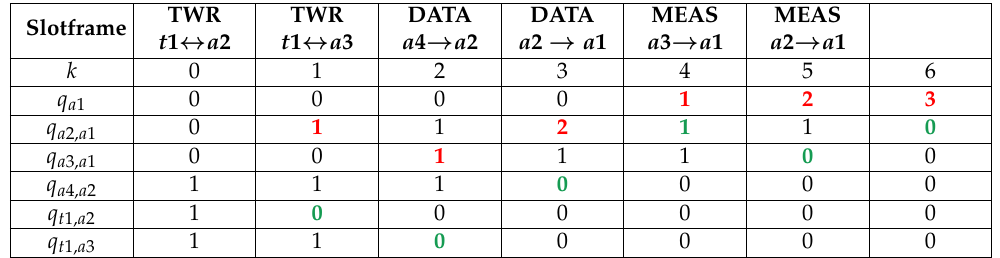
Table 4. A possible slotframe for the example network of Figure 11. Updated value are in red and final value in green.